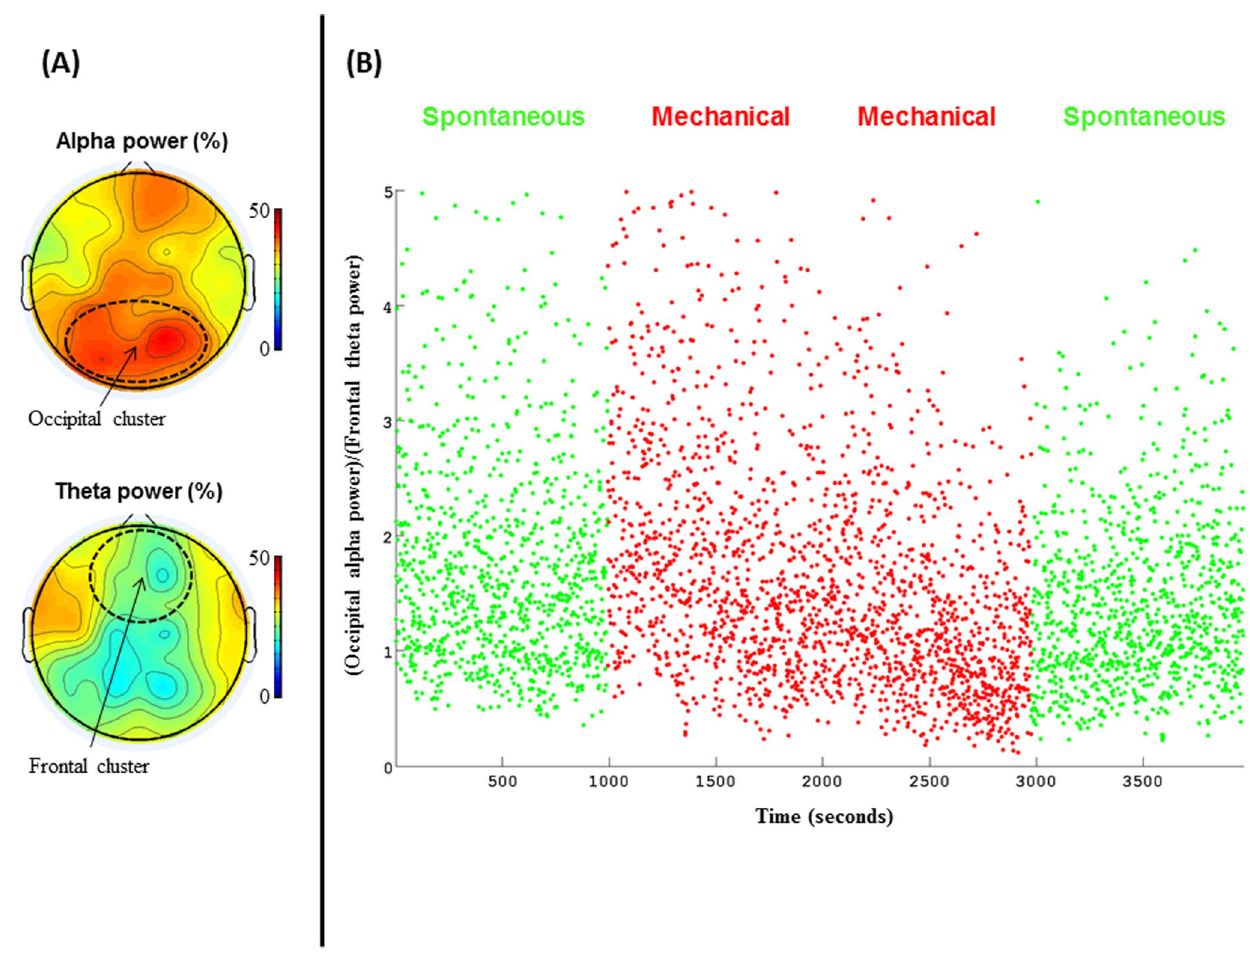
Figure 1. Stability of wakefulness under MV and SB indexed by EEG. (A). Scalp voltage topographies of alpha power (up) and theta (bottom) averaged across the 4 EEG-fMRI sessions reveal a typical pattern of wakefulness characterized by a high posterior alpha power and a low anterior mid- frontal power. (B). Dynamics of the (posterior alpha power)/(mid-frontal theta power) ration is plotted across time for the 4 EEG-fMRI sessions. This index of wakefulness was stable across the 4 sessions, and confirmed a stable level of wakefulness all along the fMRI experiments, with no difference between SB and MV.